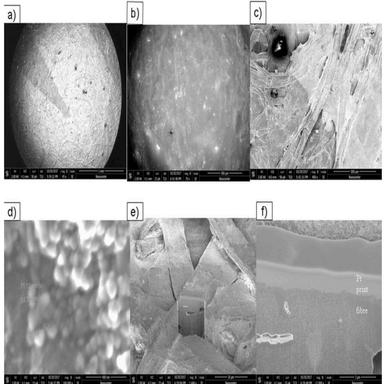
SEM-EDXS micrographs of RO paper: upper surface at low magnification a), food-facing surface at low magnification b), upper surface at 100 μm magnification c), particles in the print d), cross-section of the print area of the upper side e) and f).